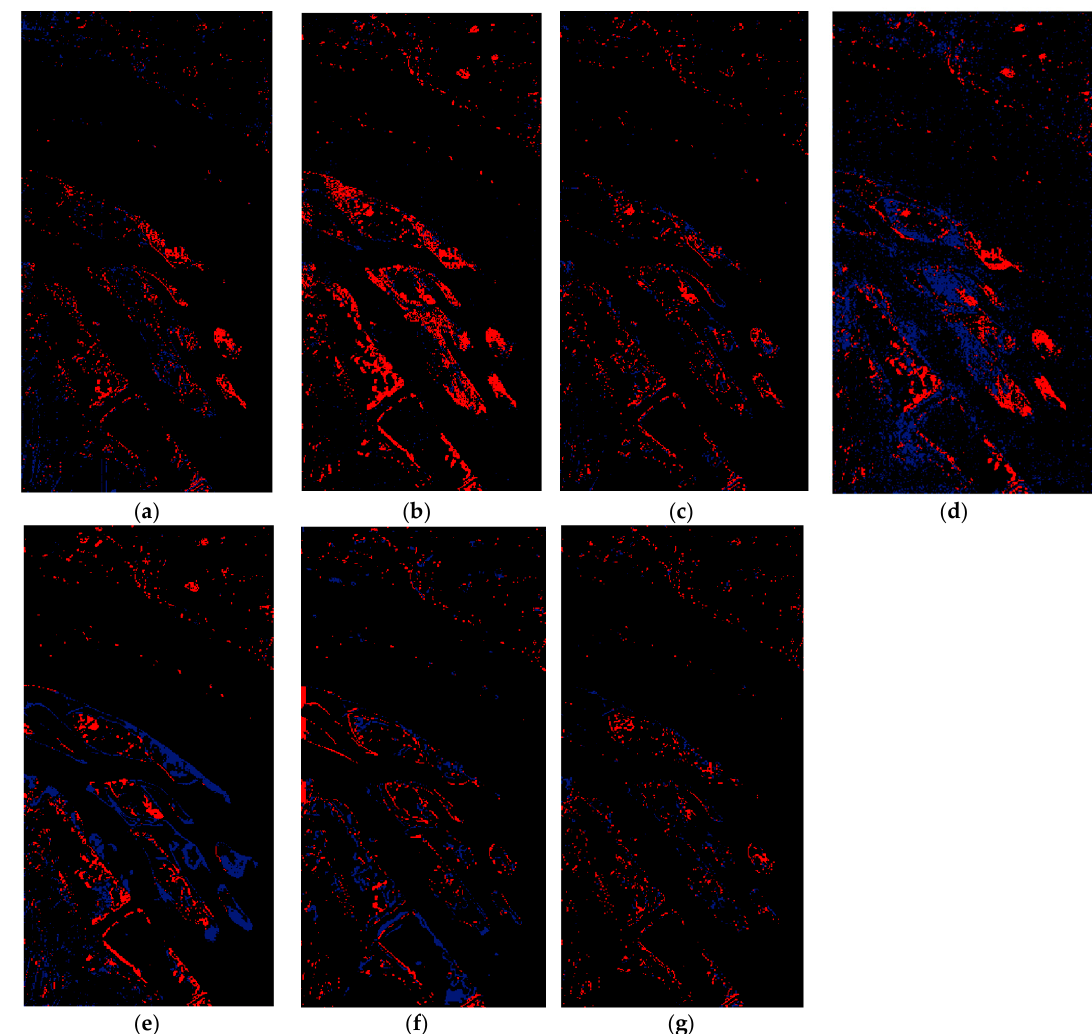
Figure 16. The change detection errors of different methods for the Hyperspectral-River dataset. ( a ) CVA-SVM, ( b ) MAD-SVM, ( c ) PCA-SVM, ( d ) IR-MAD -SVM, ( e ) SFA-SVM, (f) 3D-CNN, and ( g ) Proposed Method. Black, red, and blue colors indicate TP and TN, FN, and FP pixels respectively.